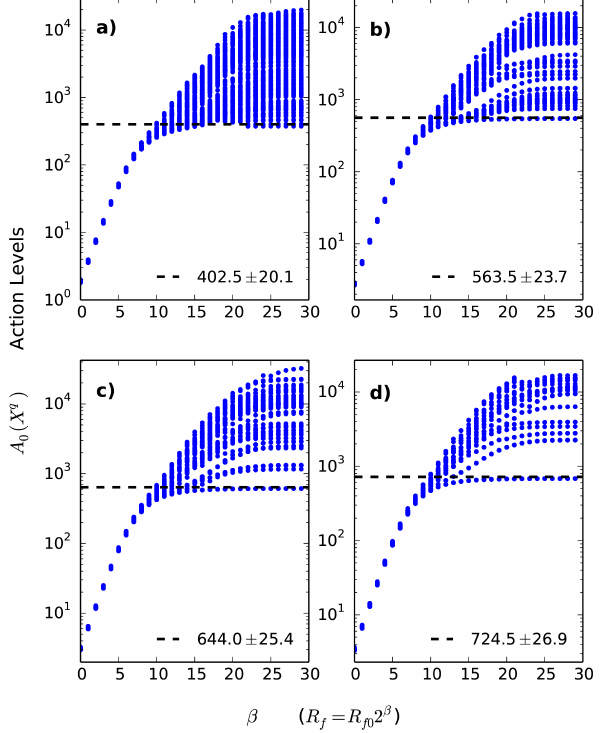
Figure 1. Action levels as a function of R f for the Lorenz96 model, D = 20, R f 0 = 0.01. (a) At L = 5, we used y 1 (t) , y 3 (t) , y 5 (t) , y 7 (t) , and y 9 (t) in the action; (b) at L = 7, y 11 (t) and y 13 (t) are added; (c) at L = 8, y 15 (t) is added; and (d) at L = 9, y 17 (t) is added. The expected values of the lowest action level are denoted by black dashed